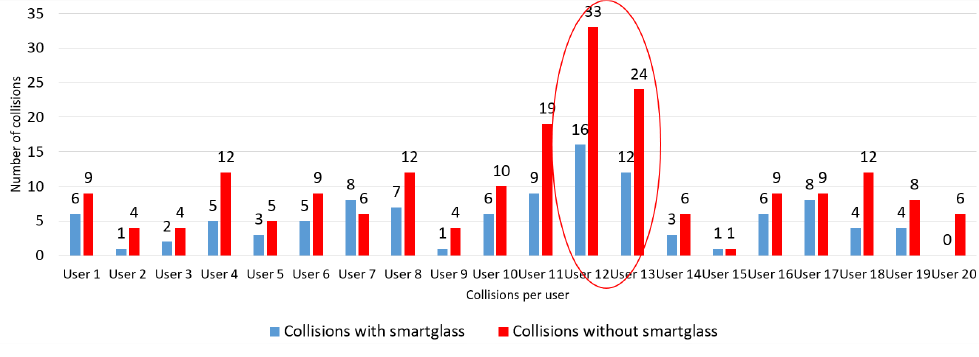
Figure 14. Cataloging of collisions by user.